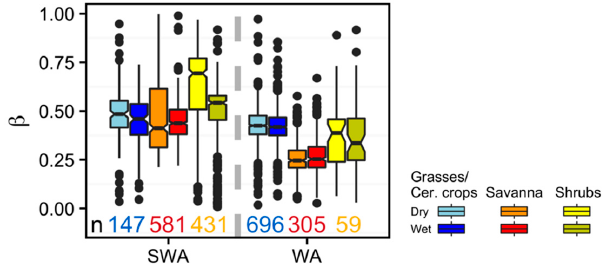
Figure 5. Vegetation response to rainfall ( β ) for different vegetation types derived from MODIS MCD12C1 Type 3 land cover data (2001–2011). Values are separated by below and above average rainfall conditions (dry/wet) for South West Africa (SWA) and West Africa (WA). Boxes are bordered by upper and lower quartiles and the median is indicated by the horizontal middle line. Whiskers indicate ±1.5 interquartile ranges. Values above and below this threshold are plotted. Notches indicate the 95% confidence interval for the median. Non-overlapping notches indicate approximate significant difference in the median, whereas n equals the number of data points per class (n of wet periods = n of dry periods).